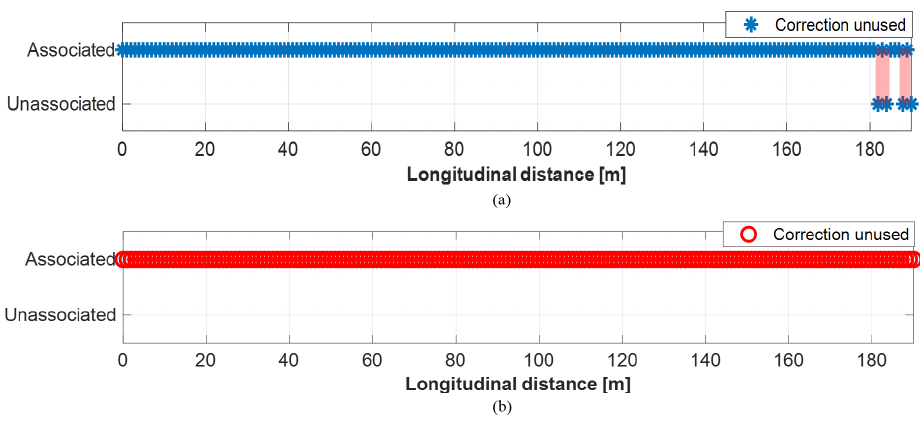
Figure 17. Object identification status of camera: ( a ) Without correction. ( b ) With correction.